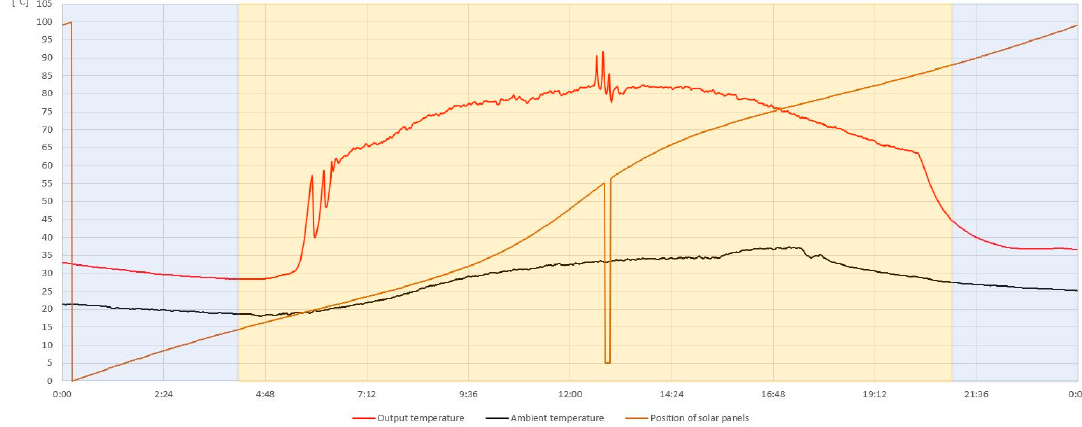
Figure 15. Circulation pump failure simulation and its effect on the system outlet temperature. Processes 2020 , 8 , x FOR PEER REVIEW